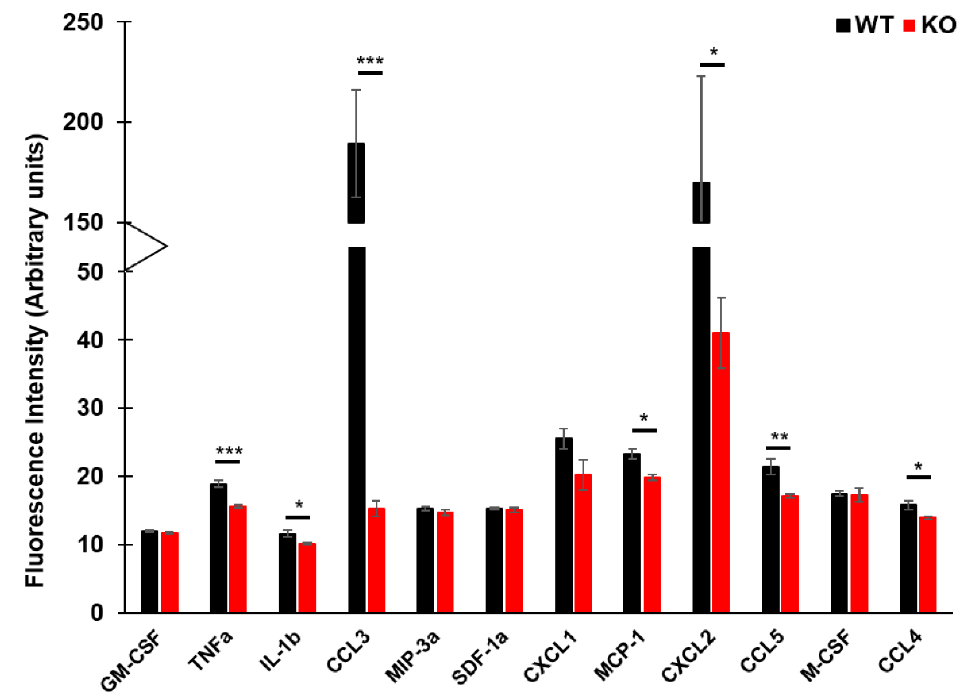
Figure 4. Bioplex analysis of various cytokines and chemokines from supernatants isolated from FLT3L-treated WT and KO HSPCs ( n = 6 mice, * p < 0.01, ** p < 0.001, and *** p < 0.0001).